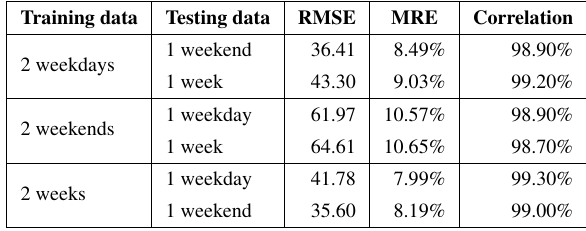
Table 2. Summary of vehicular flow prediction errors with cross-examination among different datasets using Deep